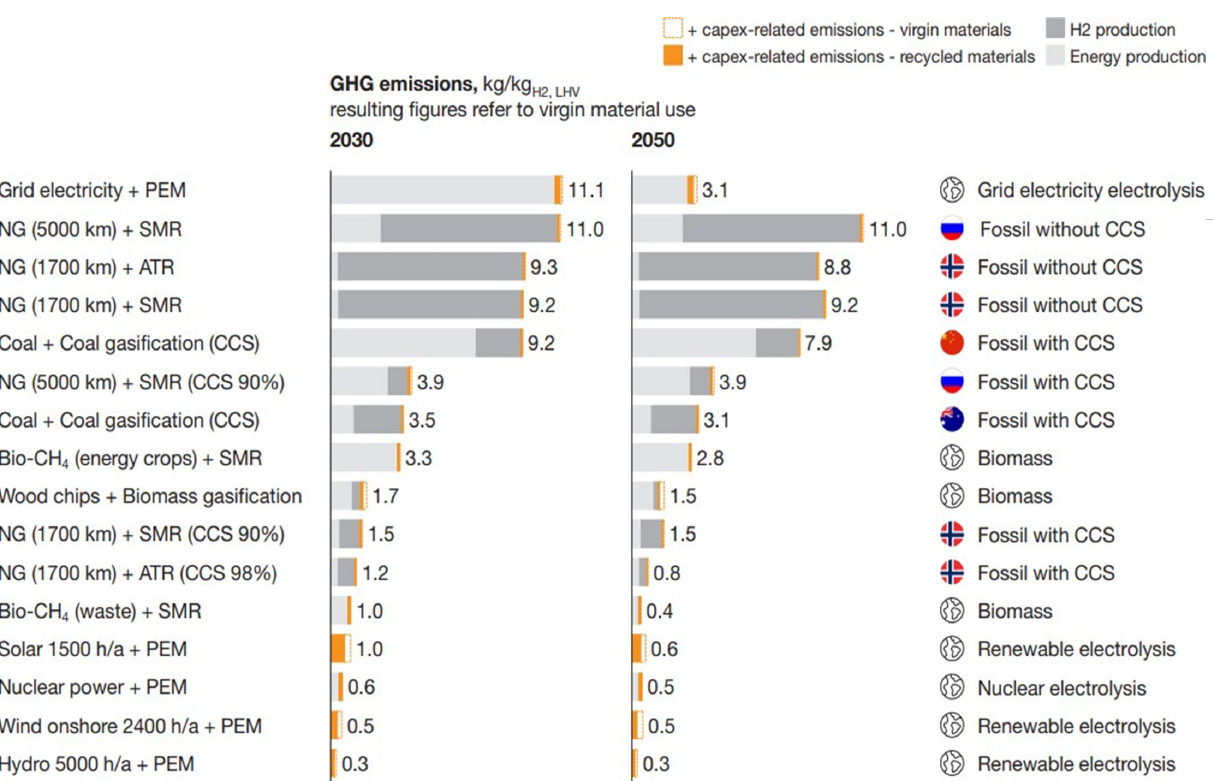
Figure 3. LCA of predicted emissions from blue, green and grey hydrogen production in 2030 [40].